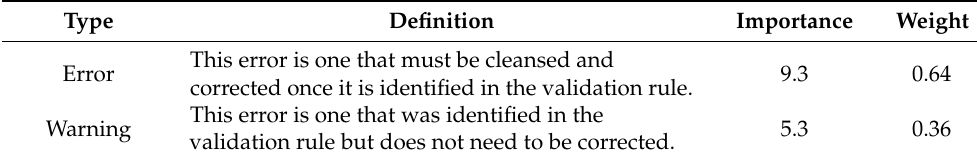
Table 2. Type definition of specialist group review.